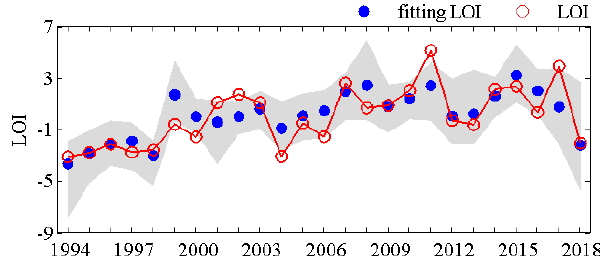
Figure 7. Combined fitting results of the regression models with R 2 > 0 . 6 both in the training dataset and the testing dataset. Note that the hollow red dots denote the low-oxygen index (LOI) estimated based on observational data, while the solid blue dots and the gray patch represent the mean values and ranges of the fitted LOI in the selected regression cases, respectively. Figure 8. Pearson correlation coefficients ( r ) among the wind